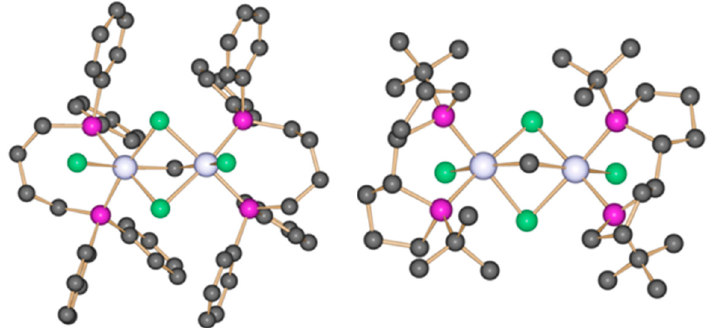
Figure 25. Molecular structure of [Rh 2 (DPPB) 2 ( µ 2 -Cl) 2 ( µ 2 -CH 2 )Cl 2 ], left, and [Rh 2 (( 1S,1S ′ ,2R,2R ′ )-TangPhos) 2 ( µ 2 -Cl) 2 ( µ 2 -CH 2 )Cl 2 ], right. Hydrogen atoms are omitted for clarity.